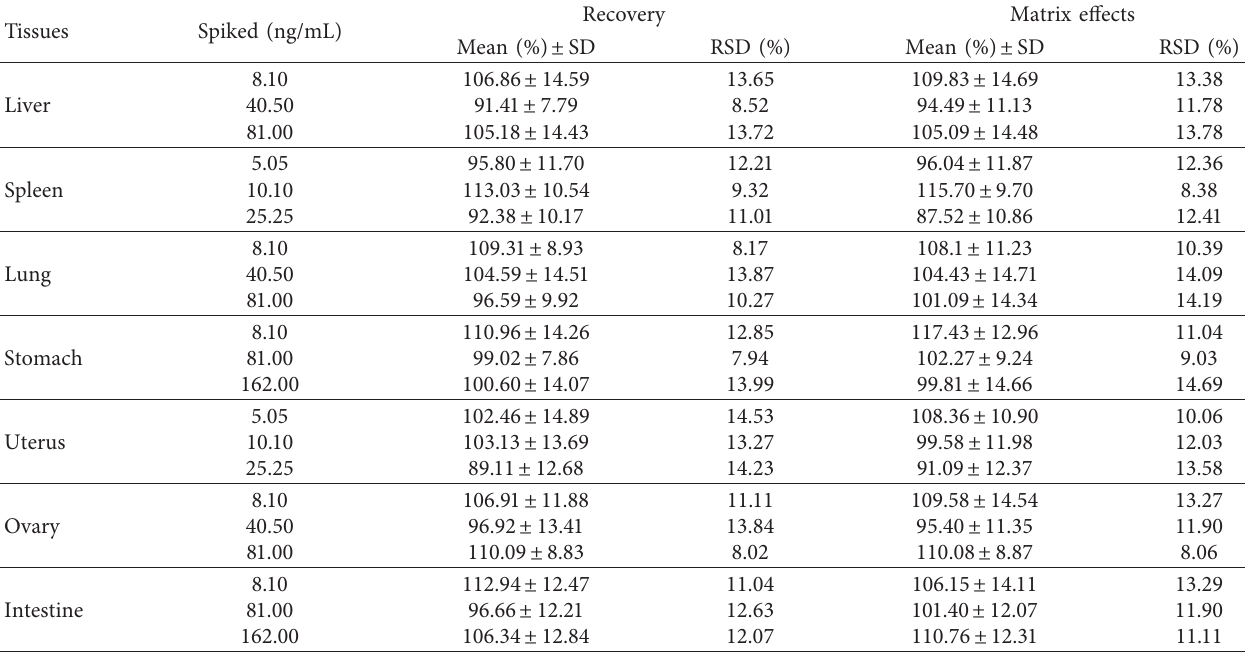
Table 14: Recovery and matrix effect study of eriodictyol in rat tissues ( n �